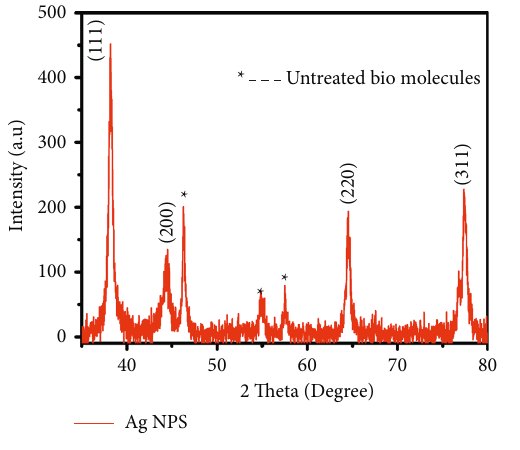
Figure 2: XRD spectra of Ag-NPs.